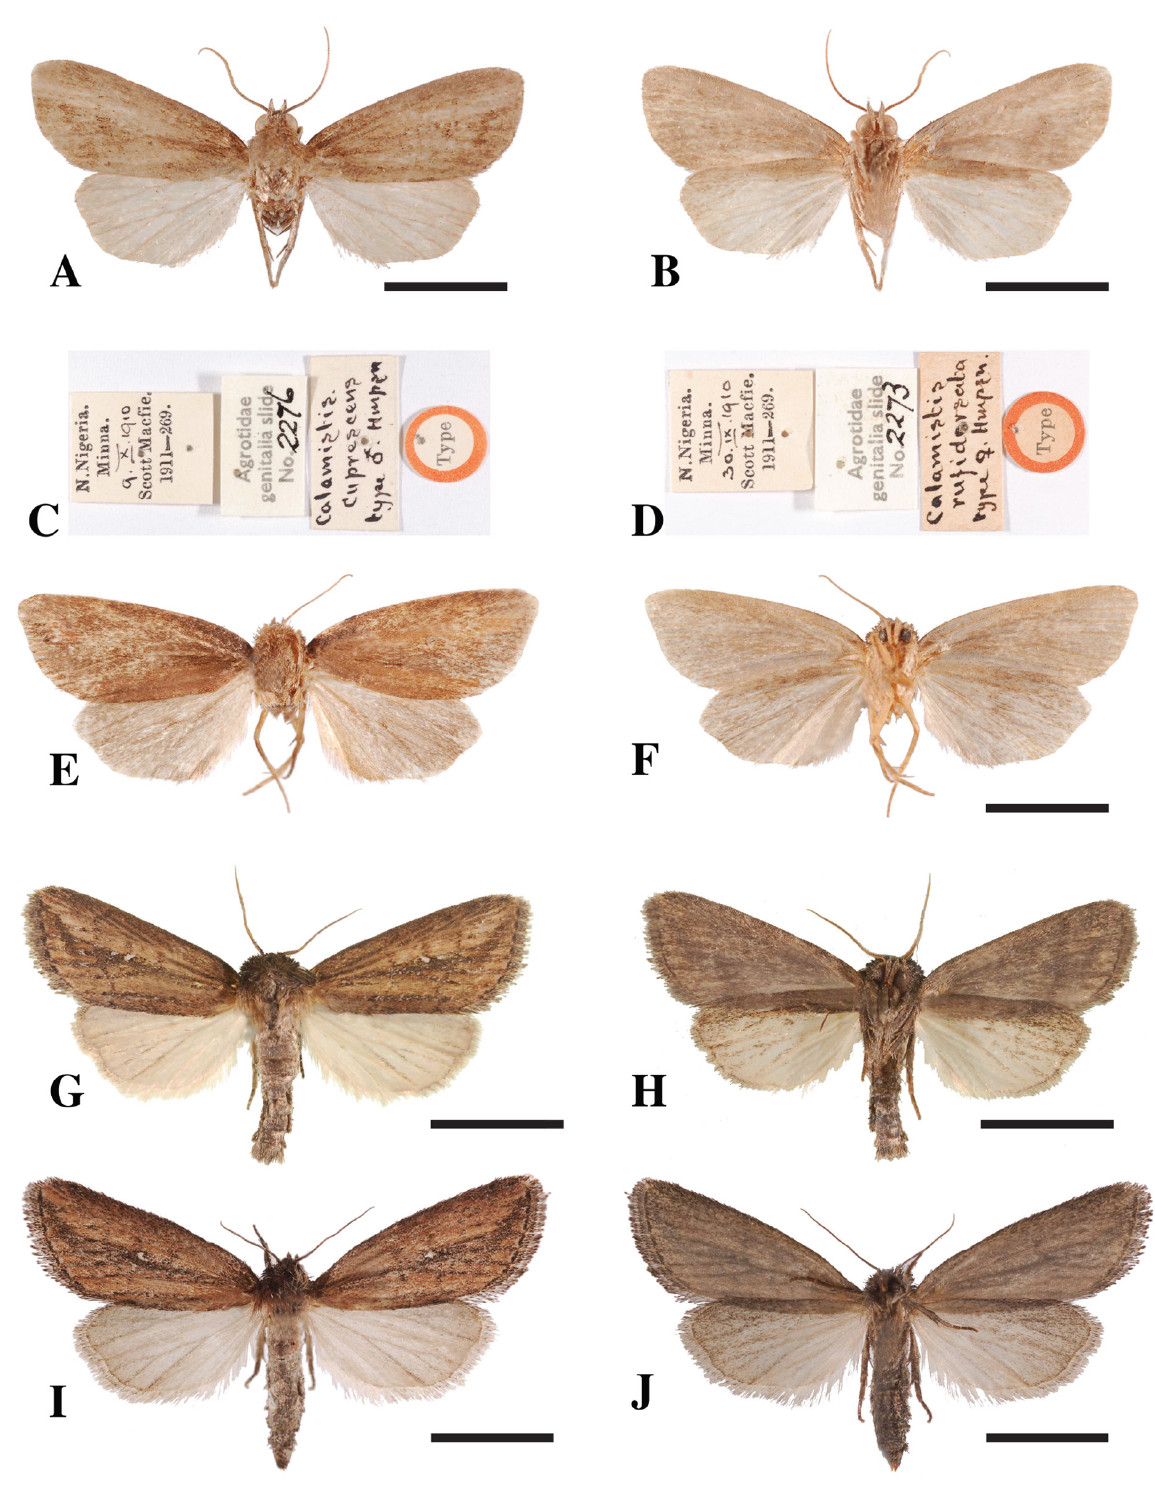
Fig. 1. Adults of species of Acrapex . – A–F . A. cuprescens (Hampson, 1910). A . ♂, upper side. B . ♂, under side. C . ♂, original labels from BMNH. D . ♀, original labels from BMNH. E . Upper side. F . Under side. – G–J . A. kafula le Ru sp. nov. G . ♂, upper side. H . ♂, under side. I . ♀, upper side. J . ♀, under side. Scale bars = 3